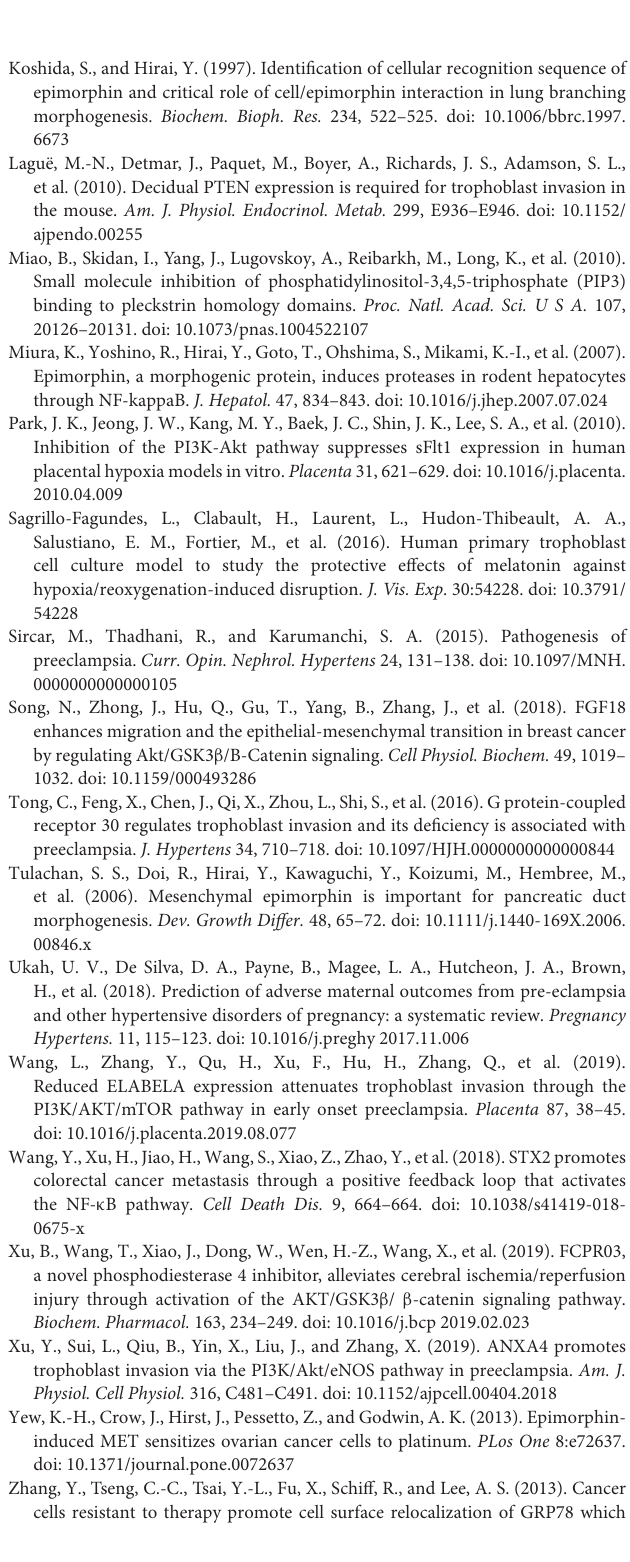
knocked down or overexpressed. (C) CCK-8 assay was used to evaluated the proliferation of control and experimental cells in which STX2 was stably transfected with or without LY294002 treatment. All the experiments were repeated three times